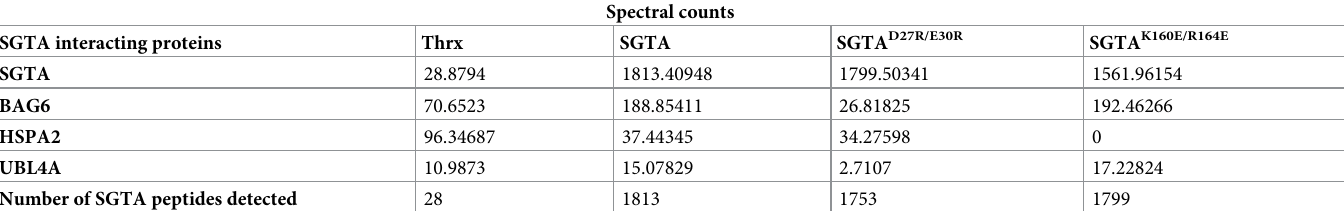
Table 1. SGTA interacting partners identified by mass spectrometry. Pull-down experiments were performed as described in Materials and Methods. The beads were then analysed for bound proteins by mass spectrometry as detailed in the materials and methods followed by interrogating the reviewed human UniProt database for SGTA interacting partners. Identified proteins known to interact with SGTA are indicated together with the spectral counts. SGTA peptides detected reflect comparative efficiency for the coupling of SGTA or the mutants to beads.